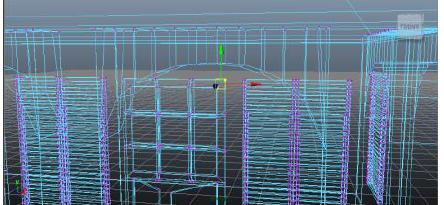
Figure 8. Build 3D primitive model by using Autodesk